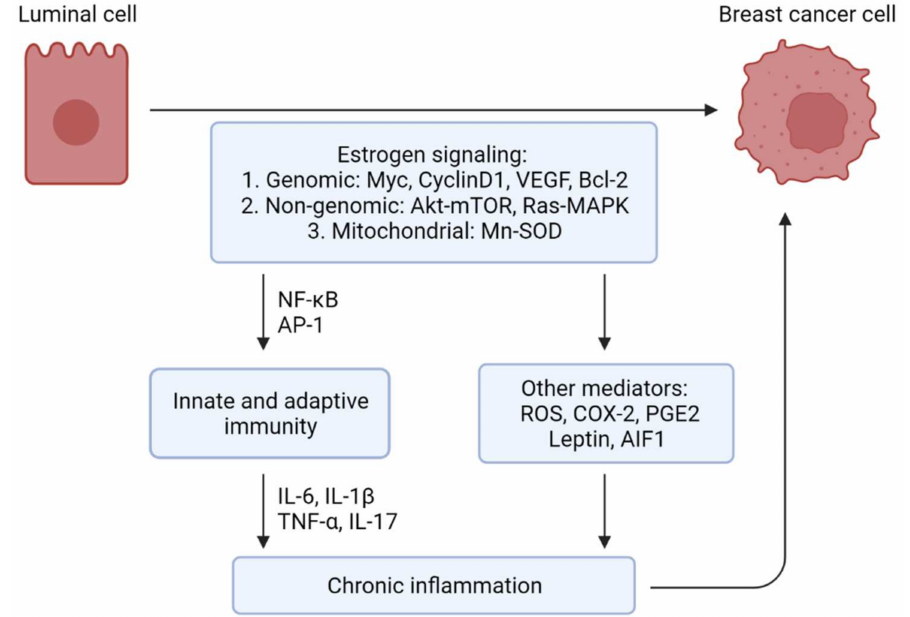
Figure 1. Schematic representation of estrogen signaling and downstream pathways regulating chronic inflammation and breast cancer etiology. Estrogen drives luminal epithelial cell transforma- tion leading to breast cancer development via genomic, nongenomic, and mitochondrial signaling pathways. Besides promoting cell survival, proliferation, angiogenesis, and metastasis, these path- ways can also modulate inflammation, innate and adaptive immunity by upregulating or activating proinflammatory mediators such as reactive oxygen species (ROS) and cyclooxygenase 2 (COX-2). Estrogen-induced chronic inflammation is an important co-conspirator in breast cancer development and progression. The anti-inflammatory function of ER signaling is also documented in pathophysi- ology but not discussed here. Key abbreviations: VEGF, vascular endothelial growth factor; MAPK, mitogen-activated protein kinase; Mn-SOD, Manganese superoxide dismutase; NF- κ B, nuclear factor- kappa B; AP-1, activator protein-1; IL, interleukin; TNF- α , tumor necrosis